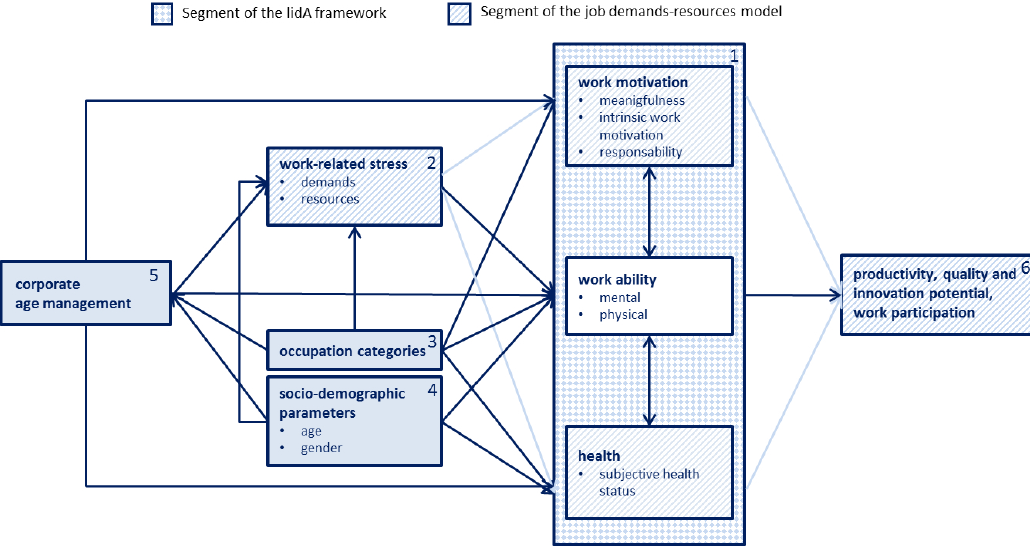
Figure 3. Suggestion for an extended model of the relation between work motivation and health (own diagram).